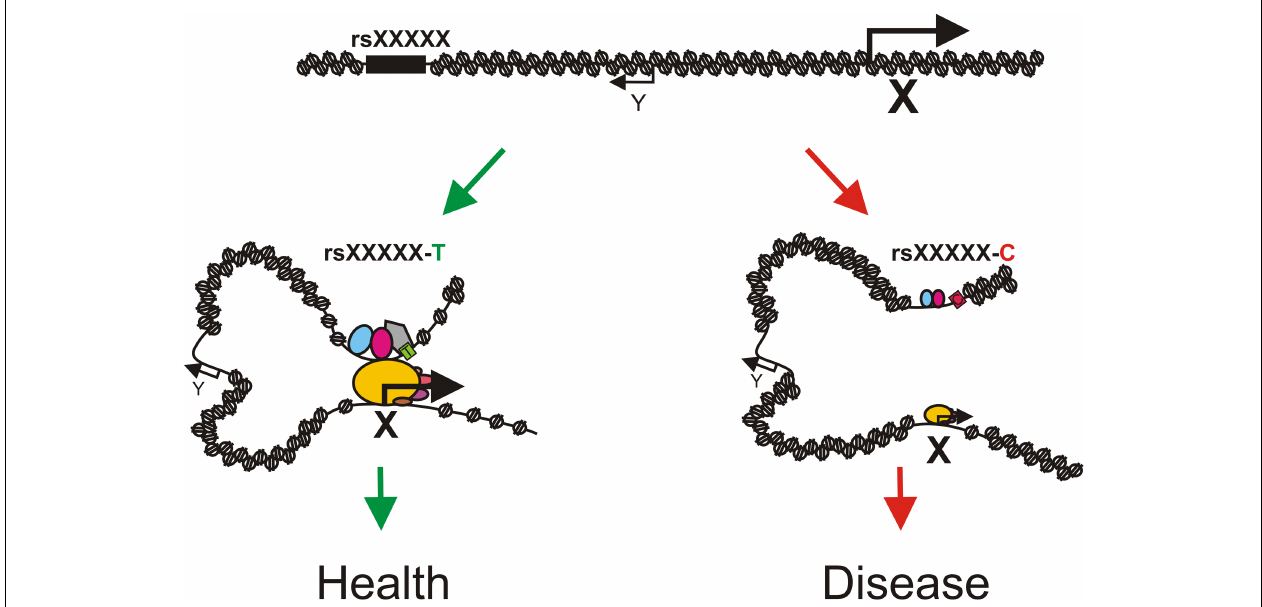
dashed border) which leads to a less efficient enhancer, absence/reduction of looping and diminished expression of gene X resulting in aberrant or deviated development (right, red arrows). Note that geneY is located in between the enhancer and gene X and is not regulated by the enhancer. Pentagons depict enhancer bound transcription factors and ovals depict components of the pre-initiation complex. Size of the icons depicts strength of binding or